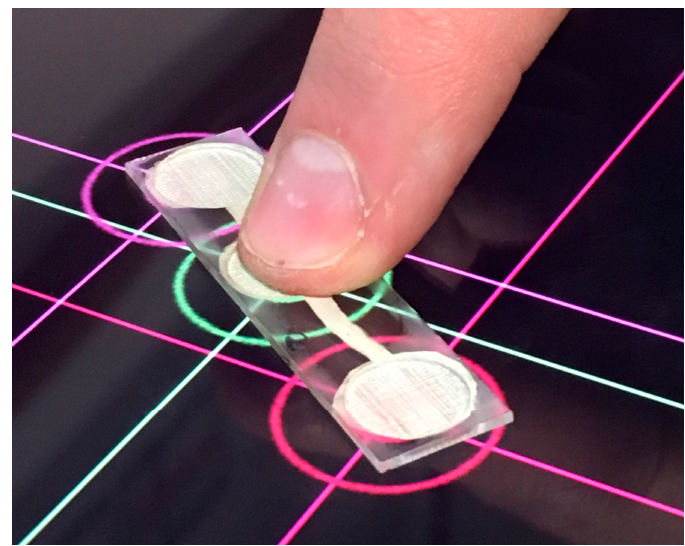
Figure 5. Capacitive marker (10 mm pad diameter) fabricated by laser cutting in use on capacitive touch screen. The colored rings and hair crosses indicate that each individual pad has been recognized as separate touch point by the touch screen. The microstructure resulting from the engraving process and the conductive silver varnish are also well visible.